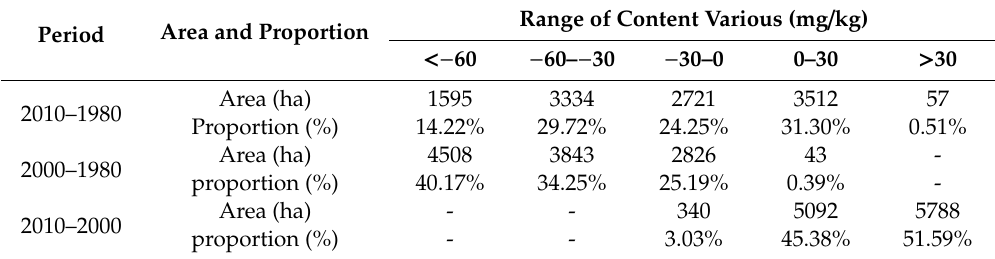
Table 2. Distribution of AVK content in cropland